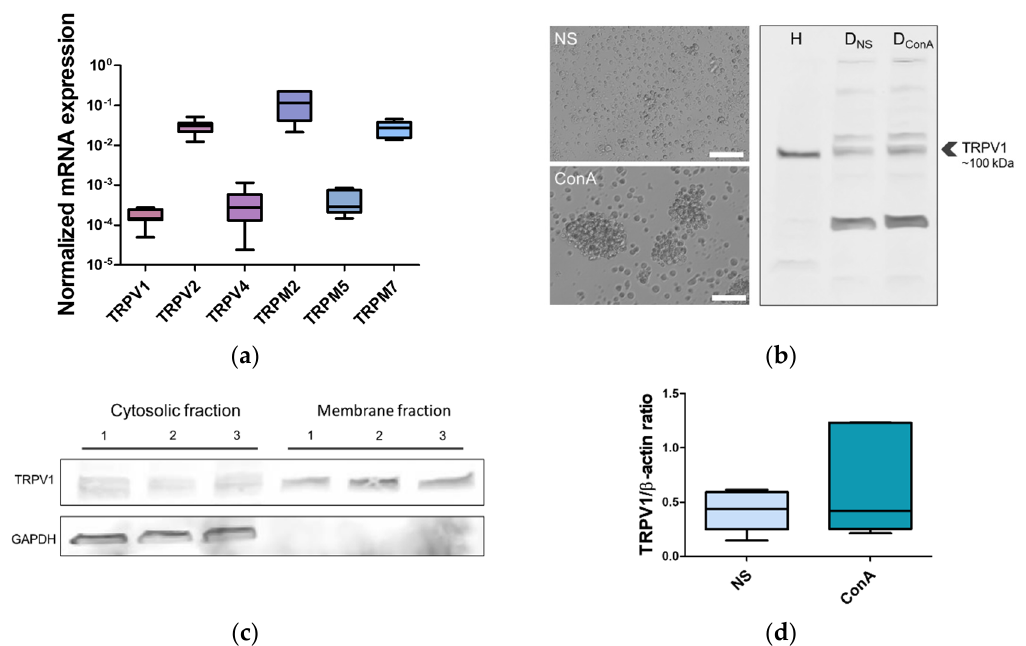
Figure 3. Expression of TRP ion channels in the canine PBMC, with special emphasis given to TRPV1. ( a ) mRNA expression of selected TRP ion channels in the canine PBMC. TRPV2, TRPM2, and TRPM7 were found to exhibit high expression, while TRPV1, TRPV4, and TRPM5 were characterized by low expression. Expression level is represented as arbitrary units. Data are shown as a dot plot, with mean ± s.e.m. ( n = 7 animals). Different letters indicate significant differences (one-way ANOVA, followed by Tukey’s post hoc, p < 0.0001). ( b ) TRPV1 protein level in the canine PBMC. TRPV1 antibody recognized a major band around ~100 kDa in the lysate of the canine PBMC. As a control of antibody specificity, we used PBMC lysate from a human (H). Western blot was run on PBMC that were not stimulated (D NS ) or activated with plant mitogen concanavalin-A (D ConA ) for 24 h. Activation was confirmed by microscopy (activated cells groups into clusters). Scale bars, 50 µ m. ( c ) Western blot’s densitometric quantification. We did not found significant differences between NS and ConA treated groups. B-actin was used as a loading control. Values are means ± s.e.m., n = 5, Student’s t -test, p < 0.05. ( d ) Western blot of cytosolic and membranous fractions from canine PBMC. TRPV1 localizes in plasma membrane; however, immunoreactive bands in cytosolic fractions suggest that it might also localize in other subcellular compartments. As a control, we used GAPDH (~40 kDa). Immunoreactive bands for GAPDH were found only in the cytosolic fractions ( n =